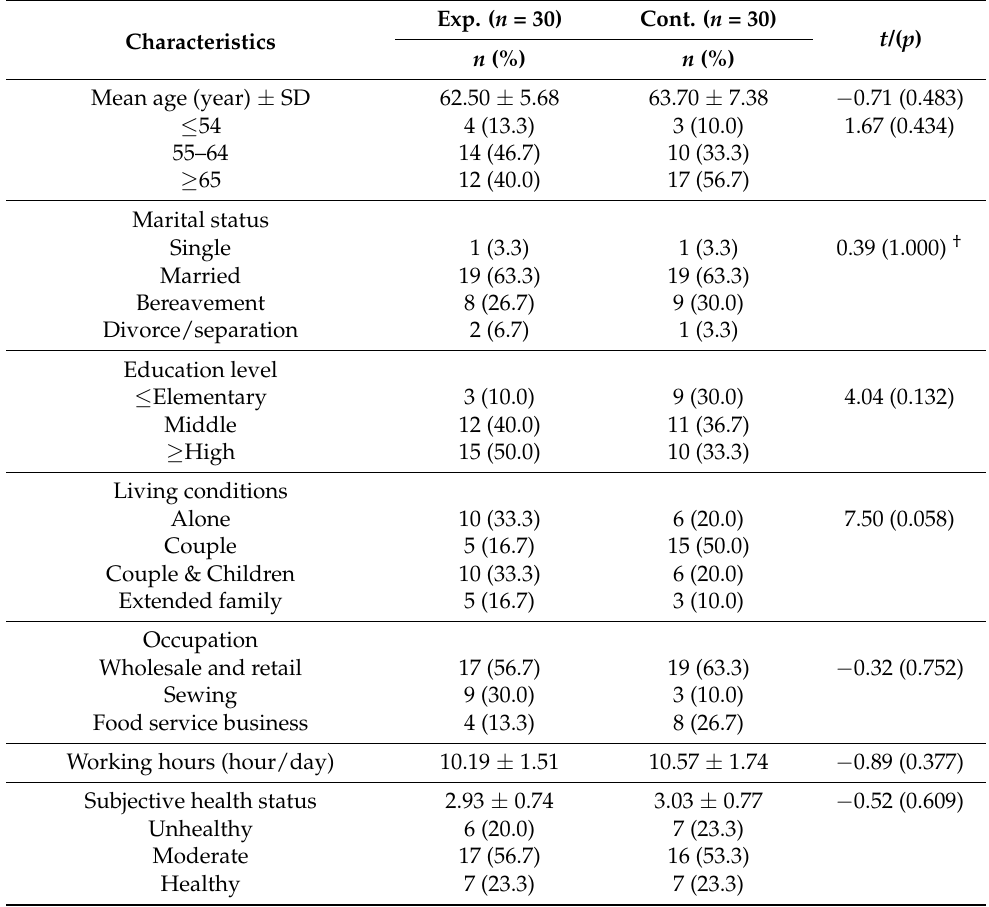
Table 1. Homogeneity test of general characteristics.